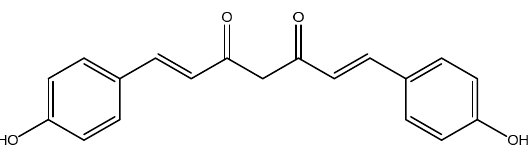
Figure 12. Chemical structure of Bisdemethoxycurcumin.